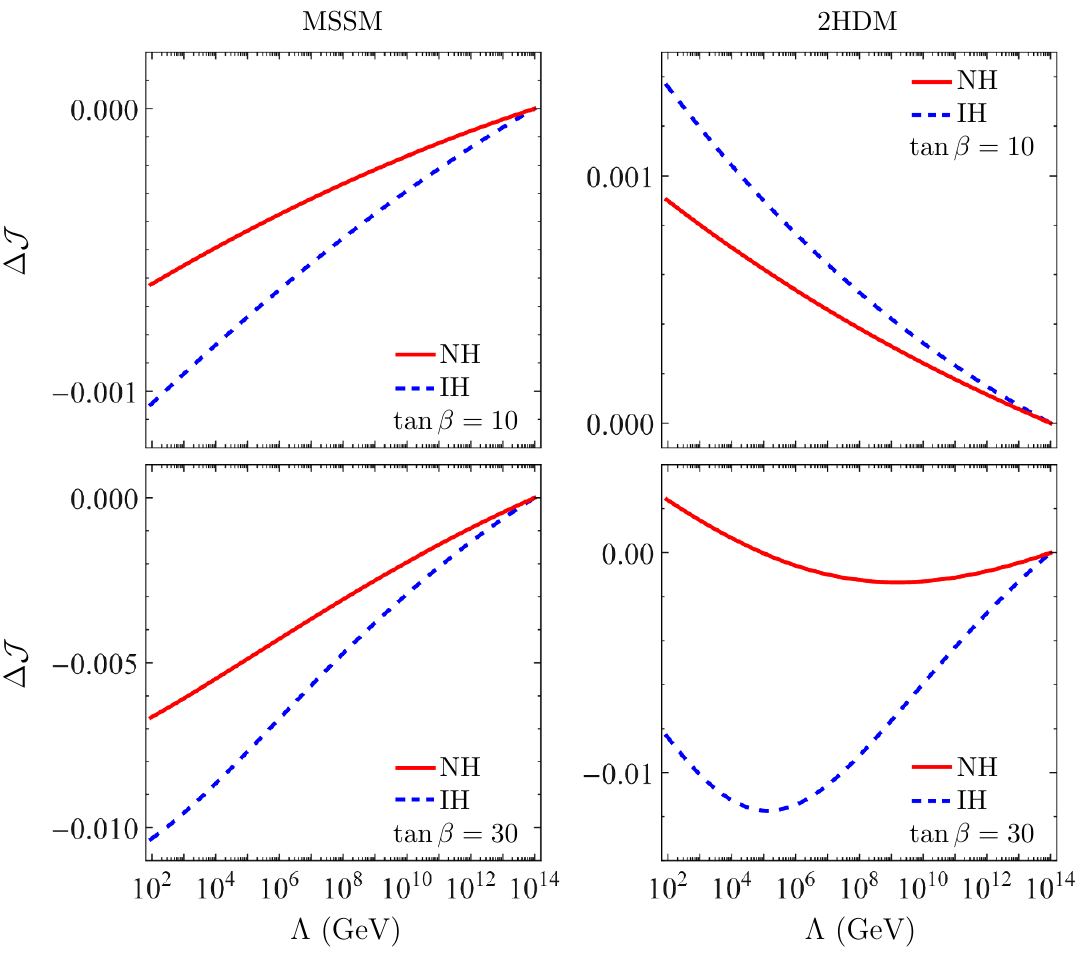
′ with the energy scale Λ in the MSSM and J ≡ J −J = 0 . 05 eV at Λ = 10 2 GeV is typically input and θ F lightest = 10 14 GeV are fixed by the µ - τ reflection symmetry. µτ